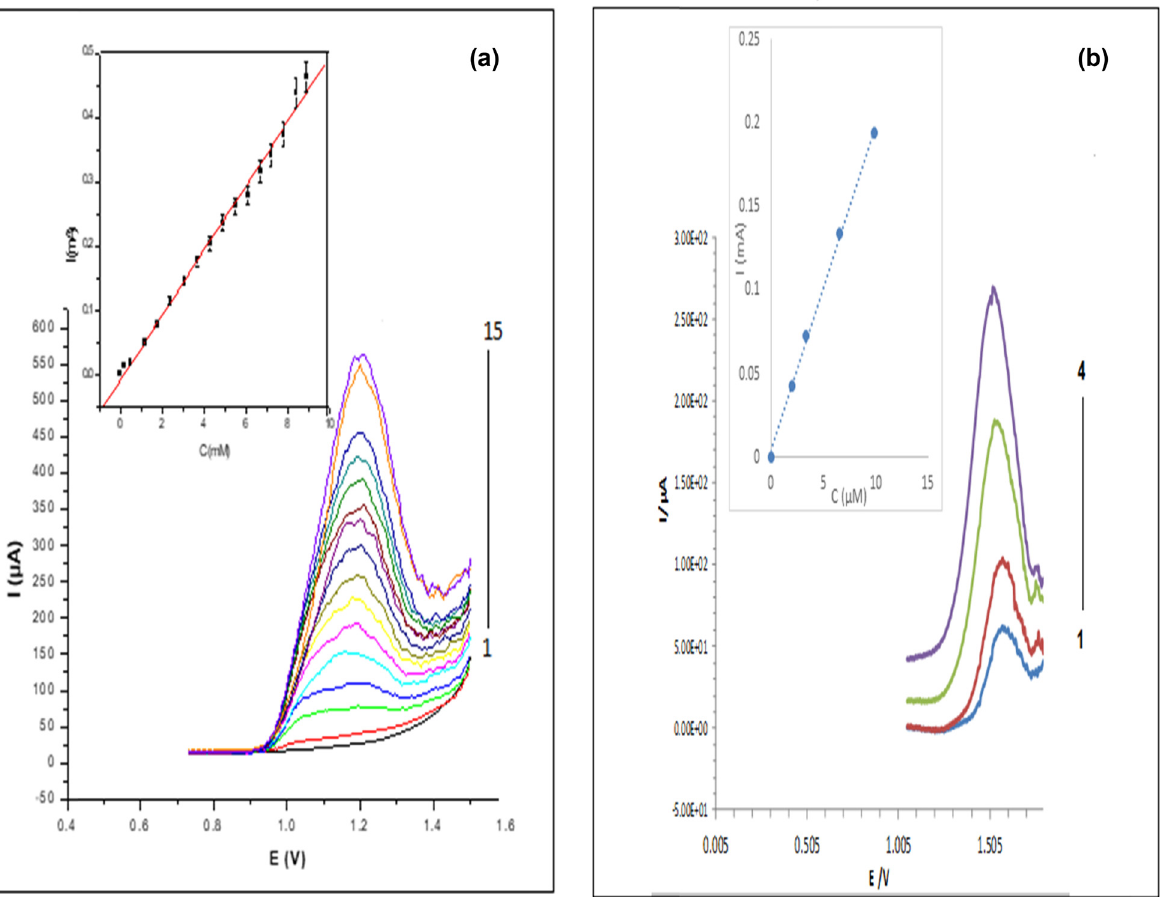
Figure 6: Square wave voltammograms obtained using a nano - ilmenite modi fi ed CPE as working electrode for: ( a ) ( 1 ) 0; ( 2 ) 0.20 mmol L − 1 ; ( 3 ) 0.5 mmol L − 1 ; ( 4 ) 1.2 mmol L − 1 ; ( 5 ) 1.8 mmol L − 1 ; ( 6 ) 2.4 mmol L − 1 ; ( 7 ) 3.1 mmol L − 1 ; ( 8 ) 3.7 mmol L − 1 ; ( 9 ) 4.3 mmol L − 1 ; ( 10 ) 4.9 mmol L − 1 ; ( 11 ) 5.5 mmol L − 1 ; ( 12 ) 6.1 mmol L − 1 ; ( 13 ) 6.7 mmol L − 1 ; ( 14 ) 7.8 mmol L − 1 ; ( 15 ) 8.9 mmol L − 1 of PROP in 0.1 mol L − 1 of H ( b ) ( 1 ) 2.0 µmol L − 1 ; ( 2 ) 3.3 µmol L − 1 ; ( 3 ) 6.6 µmol L − 1 ; ( 4 ) 9.9 µmol L − 1 of ATN in 0.1 mol L − 1 of H